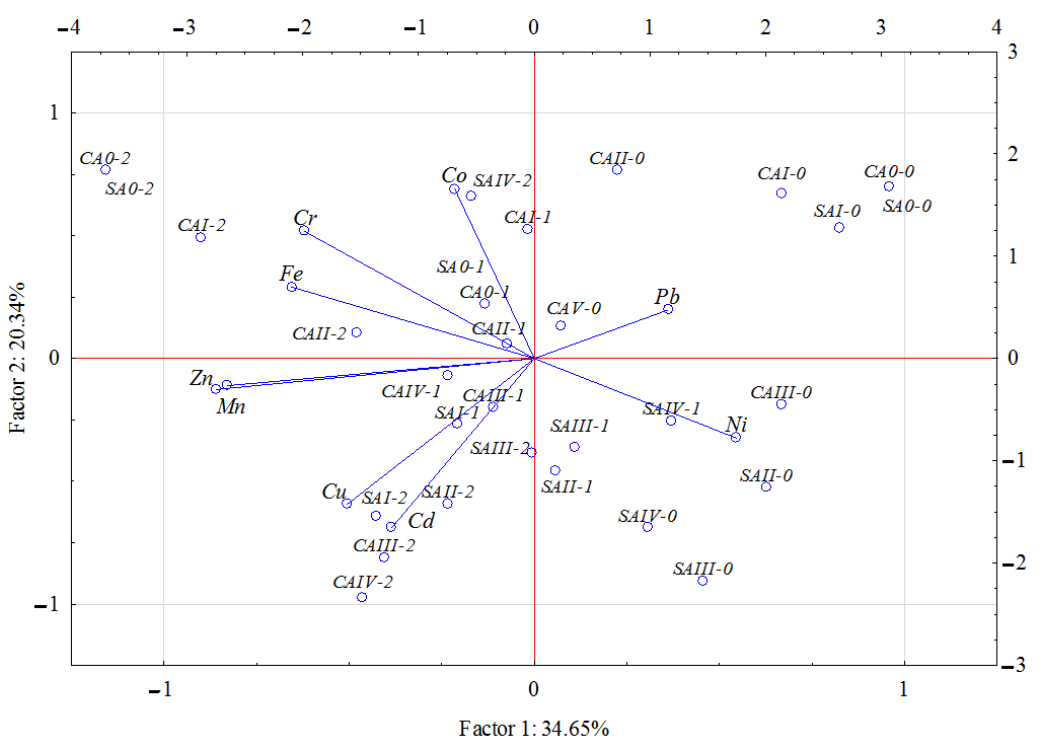
Figure 1. Content of trace elements in the above-ground parts of maize ( Zea mays L.) illustrated with the PCA method. Key: vectors represent analyzed variables (content of Cd, Pb, Cr, Ni, Zn, Cu, Mn, Fe and Co); points show the samples with elements ( CA0— without coal ash, CAI— 0.25 g, CAII— 0.5 g, CAIII— 1.0 g, CAIV— 2.0 g; ash per kg DM of soil; SA0 —without sludge ash, SAI —0.25 g, SAII —0.5